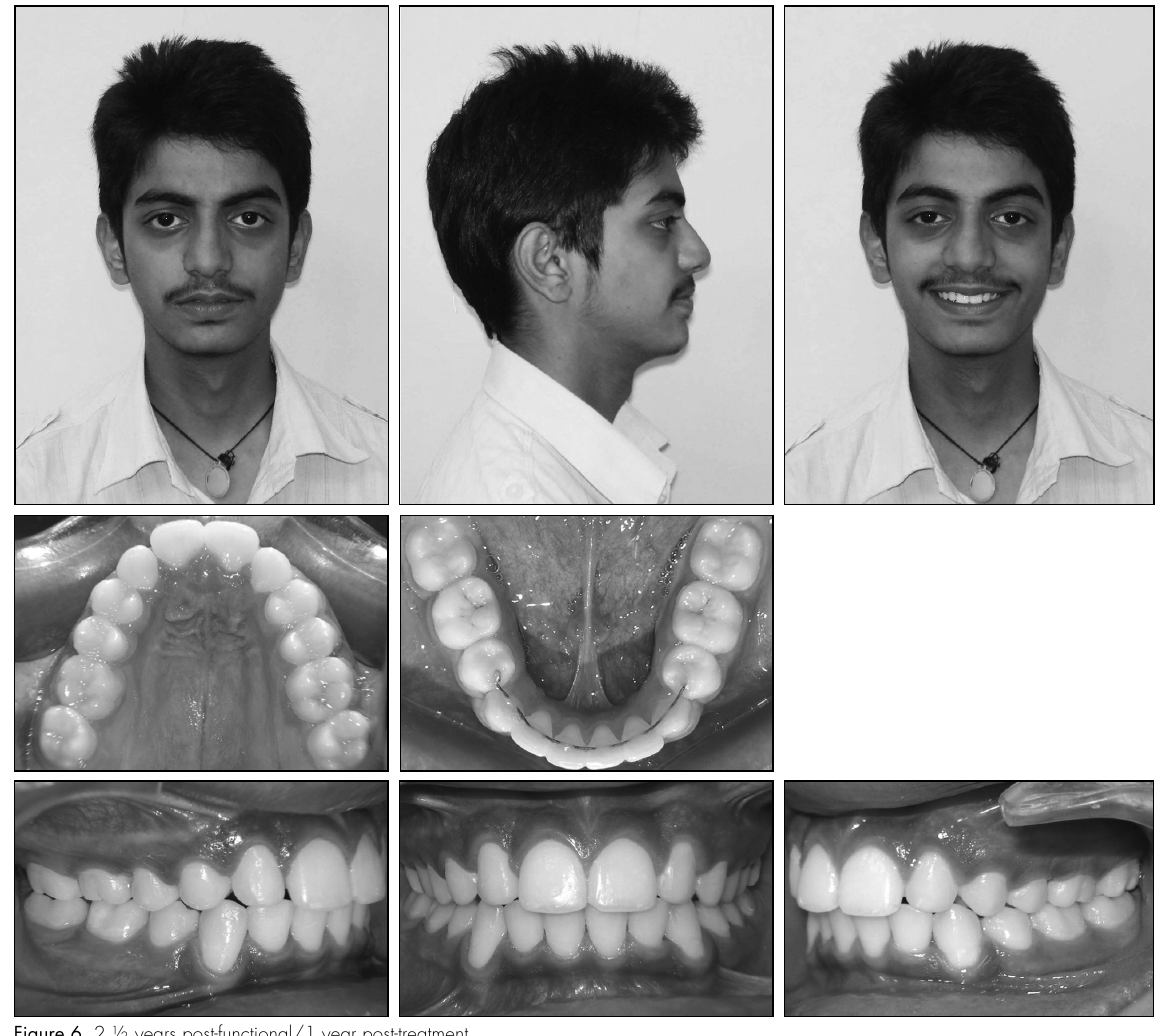
Figure 6. 2 ½ years post-functional/1 year post-treatment.